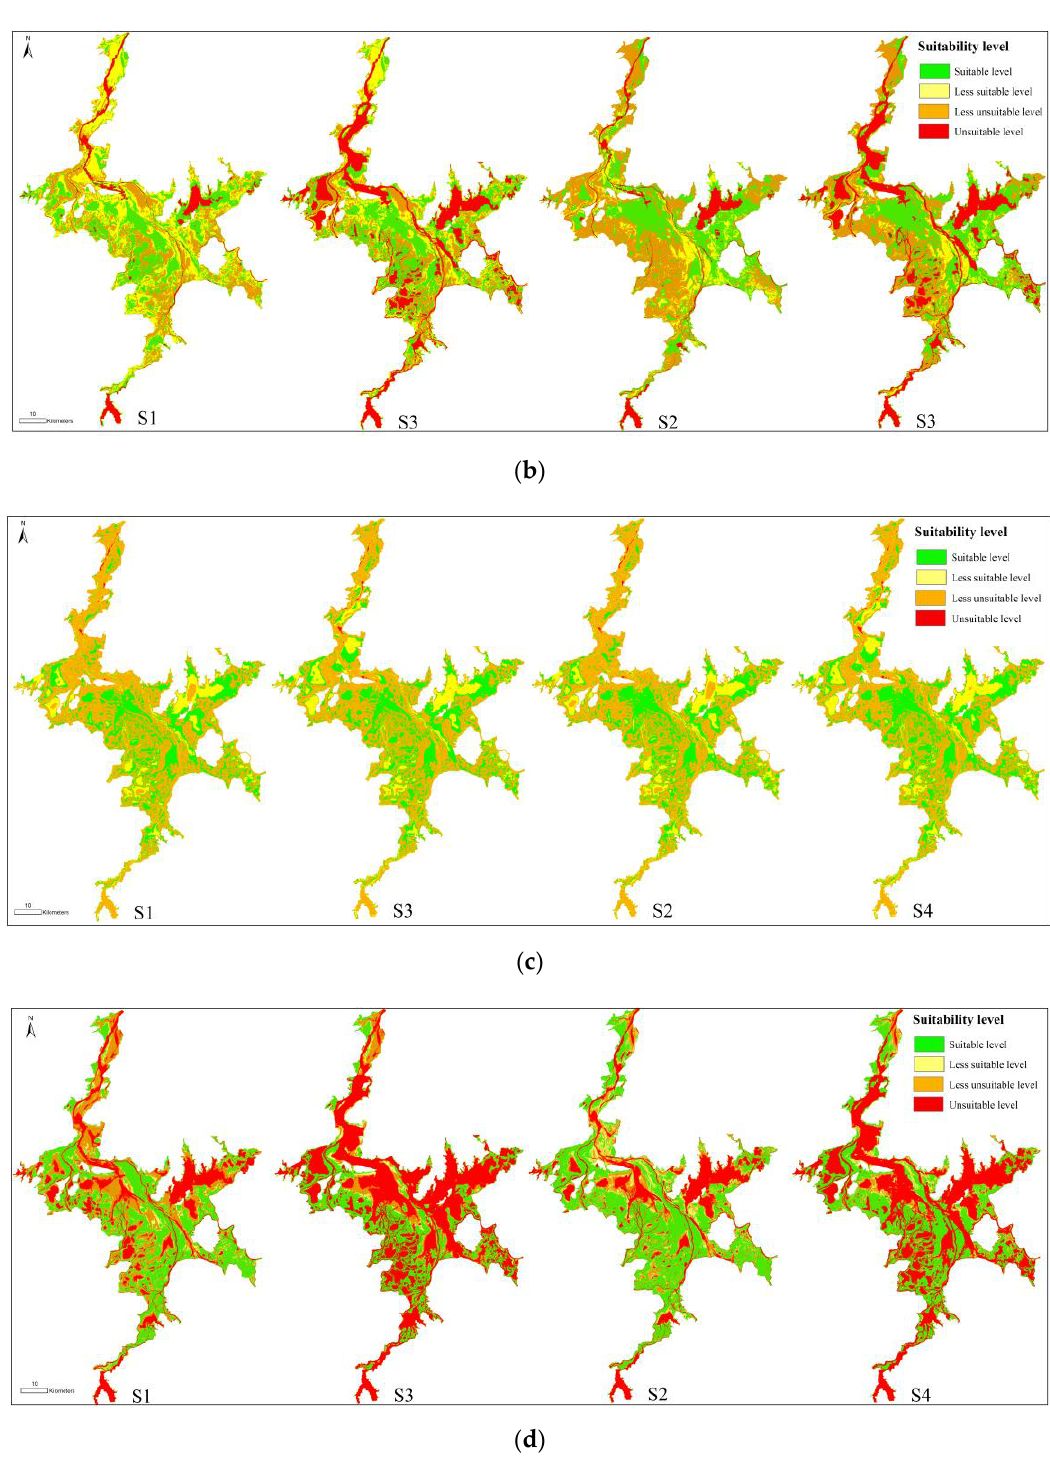
Figure 6. Migratory-bird habitat suitability of each selected habitat evaluation factor in Poyang Lake at each studied scenario. c1: Flood duration; c2: Landscape classification; c3: Water depth; c4: Vegetation coverage; c5: Distance of human activity; c6: Level of nature protection. S1: Wet year, no hydraulic project; S2: Dry year, no hydraulic project; S3: Wet year, hydraulic project present / operating; S4: Dry year, hydraulic project present / operating. ( a ) Single factor suitability of c1; ( b ) single factor suitability of c2; ( c ) single factor suitability of c3; ( d ) single factor suitability of